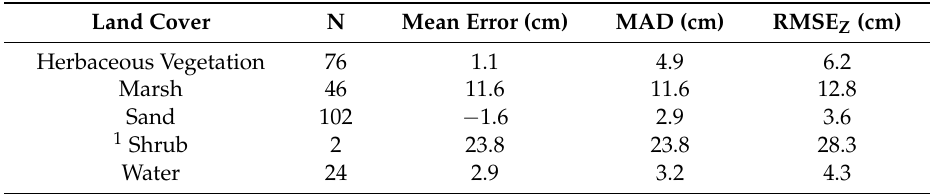
Table 1. Vertical accuracy by land cover presented as mean error, mean absolute deviation (MAD), and RMSE Z . Points were classified from the final 15-cm thematic map and manually verified. “Marsh” includes wetland vegetation; “Herbaceous Vegetation” includes non-marsh herbaceous vegetation; and “Shrub” includes woody